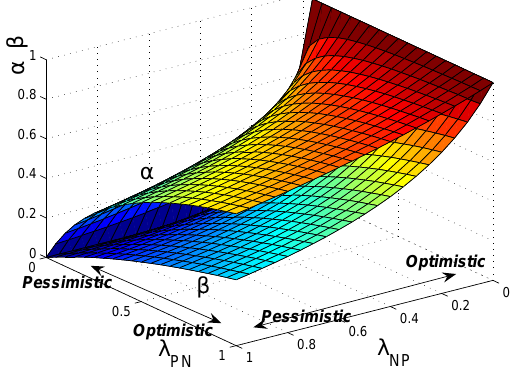
Fig. 1. Curved surface of α and β with regard to λ NP , λ PN .